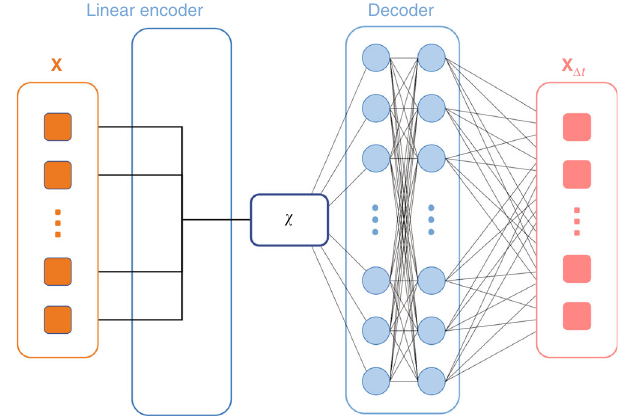
Fig. 1 Network architecture used for learning predictive information bottleneck χ . The decoder Q ( X Δ t | χ ) is a stochastic deep neural network, while the encoder P ( χ | X ) is of a simple deterministic and thus